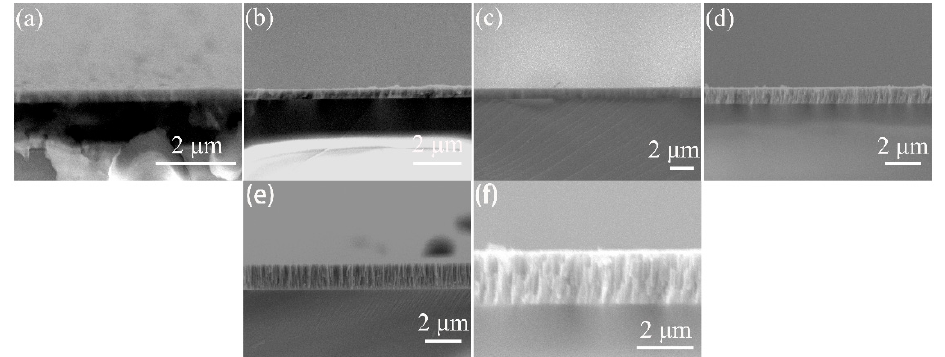
Figure 3. Cross-sectional SEM views of the Fe films fabricated at different sputtering powers: ( a ) 160 W, ( b ) 230 W, ( c ) 260 W, ( d ) 283 W, ( e ) 360 W, and ( f ) 420 W.